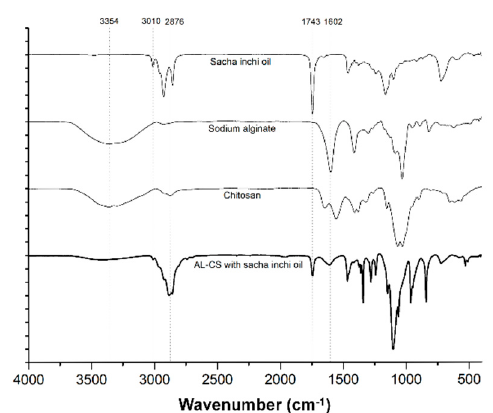
Figure 7. Fourier-transform infrared attenuated total reflectance (FTIR-ATR) of sacha inchi oil, AL, CS, and a sample of AL-CS nanoparticles with sacha inchi oil.